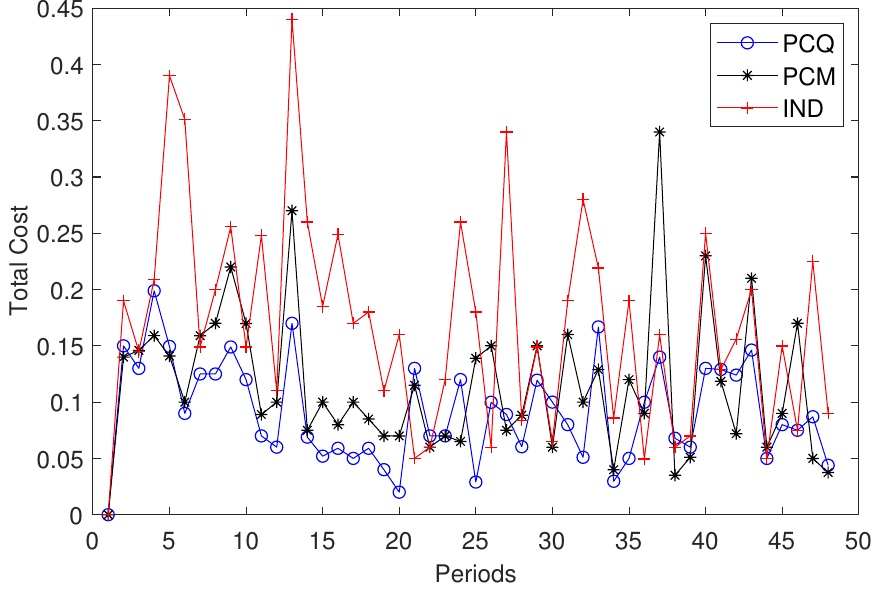
Figure 17. Variation of the total cost for each time period in the case of time period = 10